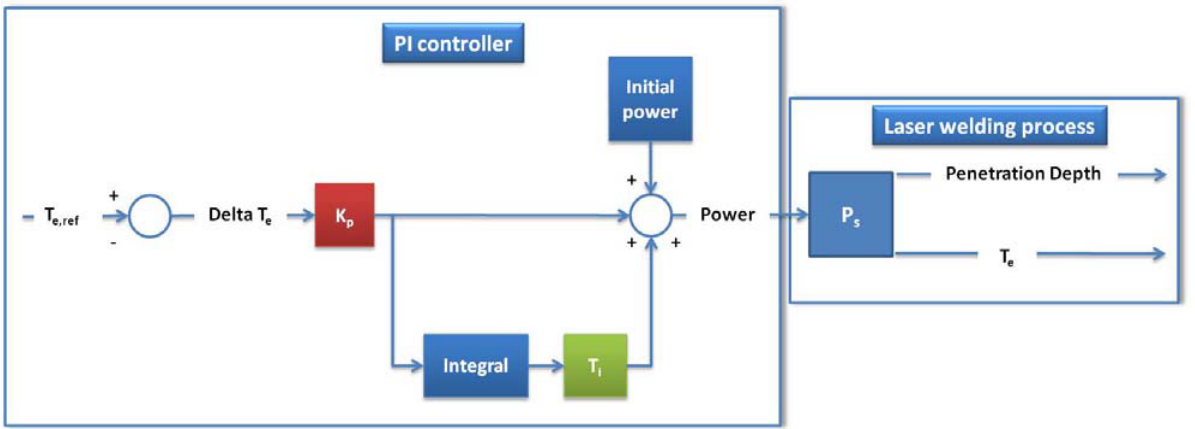
Figure 2. Controller layout.